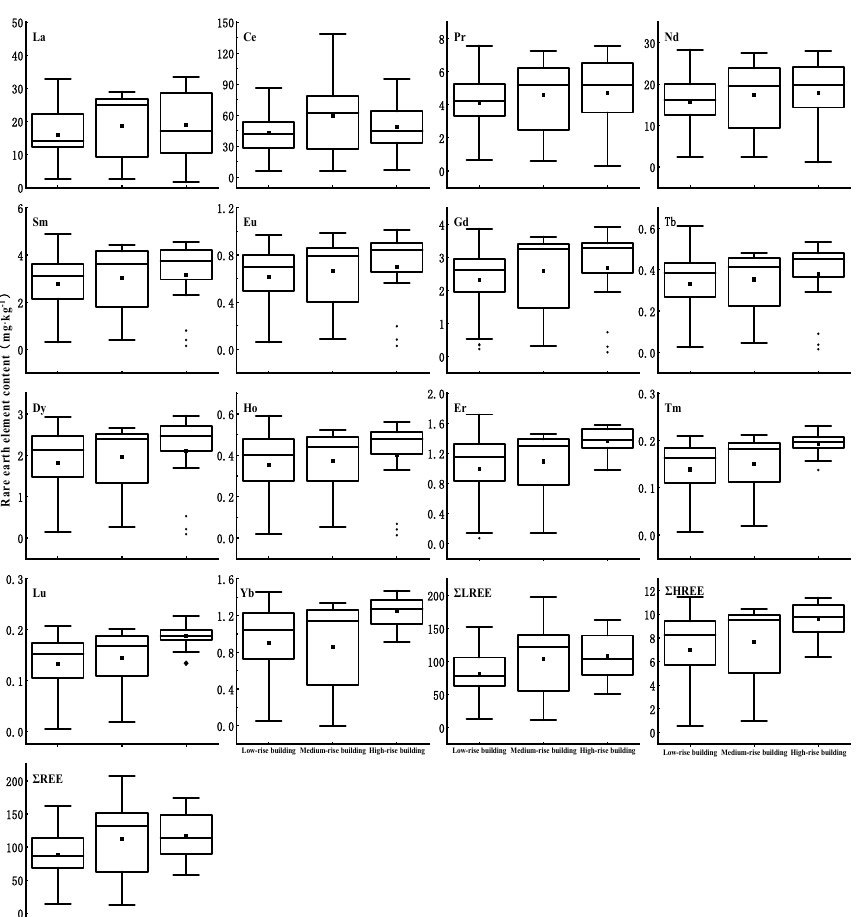
Figure 5. Box plot of rare earth element contents in atmospheric dust fall on buildings differing in height.